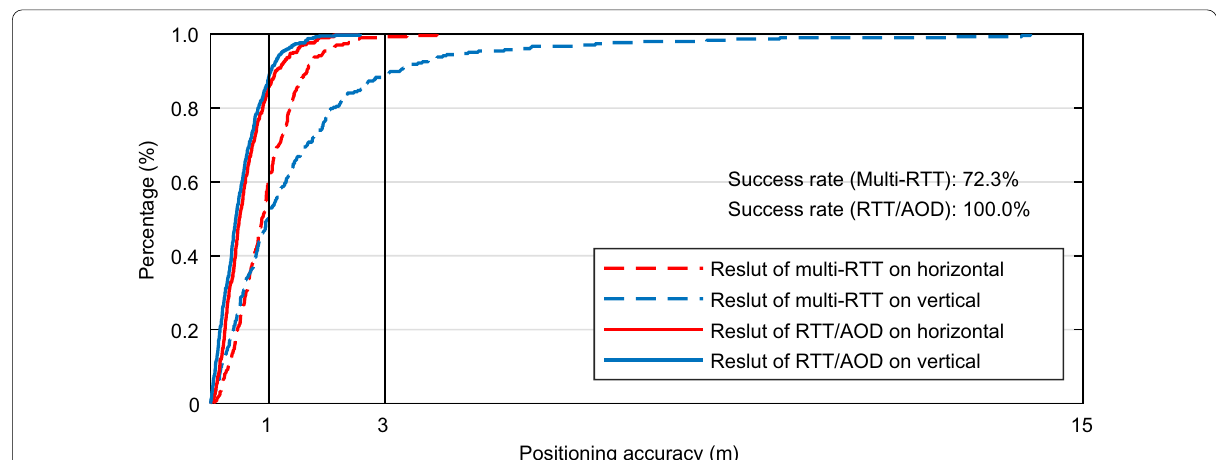
Fig.12 The Cumulative Distribution Function (CDF) of the accuracy of Multi-RTT and RTT/AOD positioning in a complex